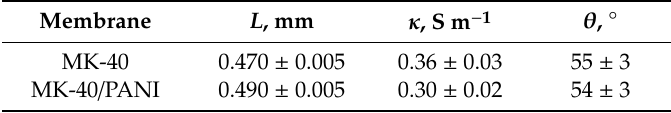
Table 1. The main properties of the MK-40 and MK-40 / PANI